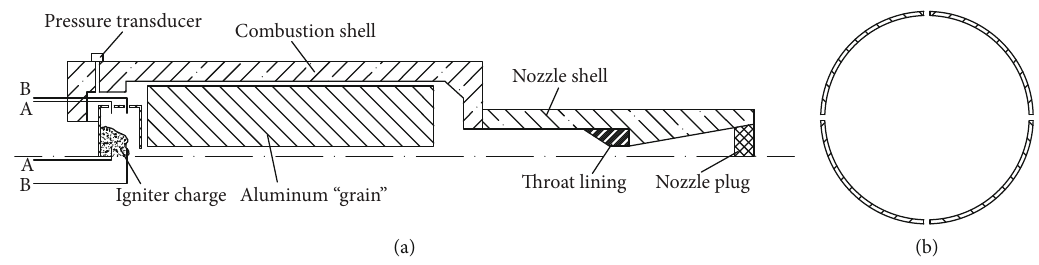
Figure 2: Schematic of the SRM. (a) Longitudinal section of the motor. (b) Igniter cross sections A-A and